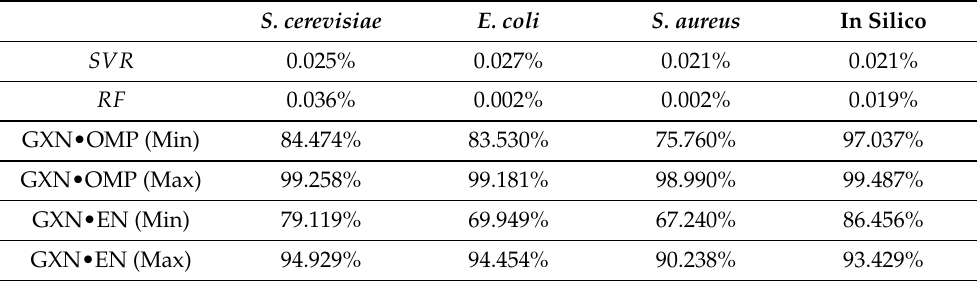
Table 2. Sparsity level for each DREAM5 dataset, and each algorithm, GXN•OMP and GXN•EN models exhibit high sparsity levels unlike SVR and RF state-of-the-art models. S. cerevisiae E.